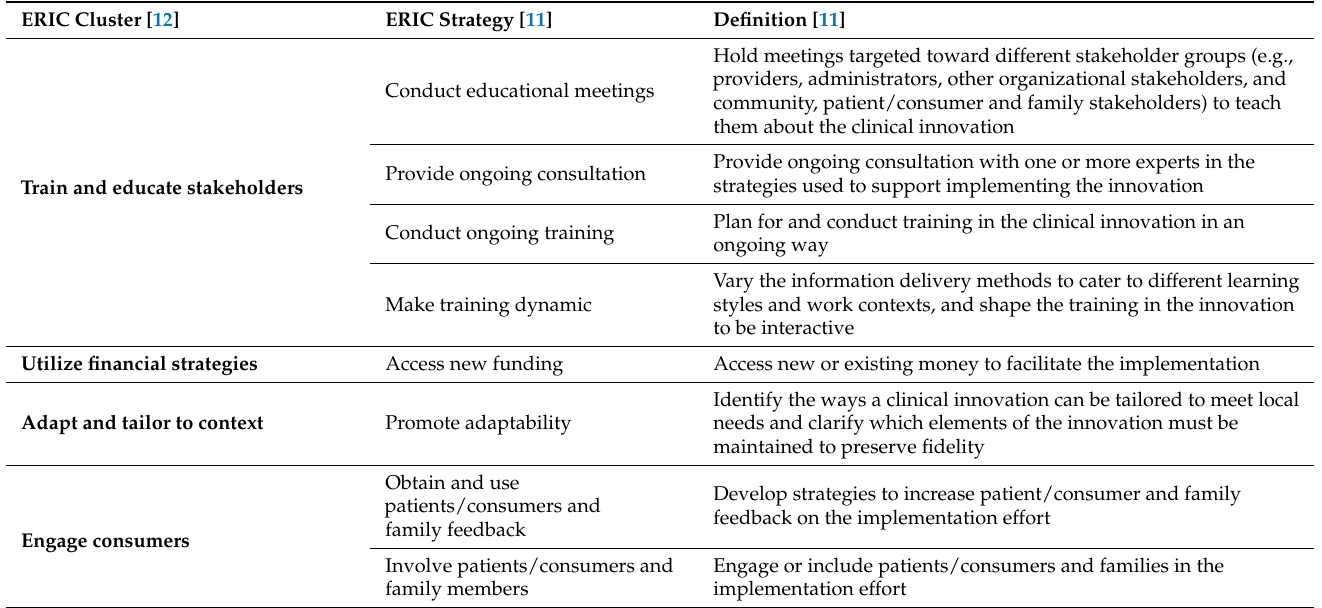
Table 5. Implementation enhancement